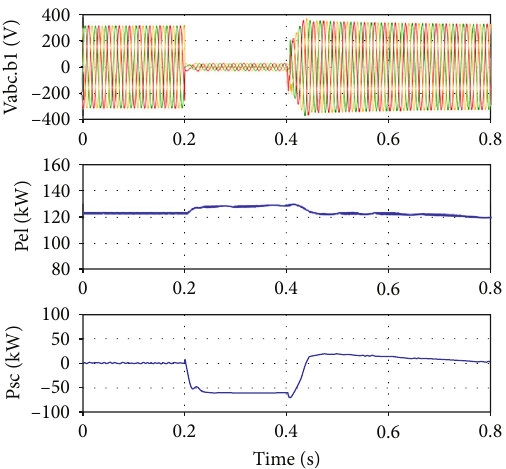
Figure 12: AC bus voltages, electrolyzer power, and SC power during an AC bus fault.